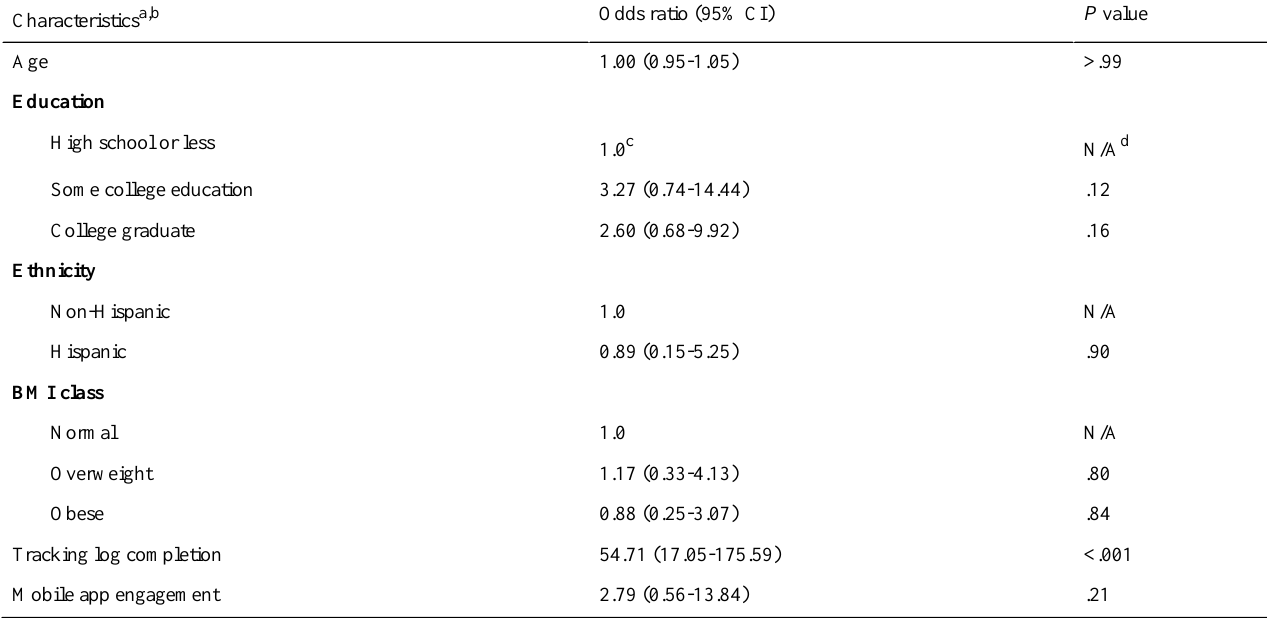
Table 3. Predictors of baseline compliant data and association with demographic and anthropometric characteristics